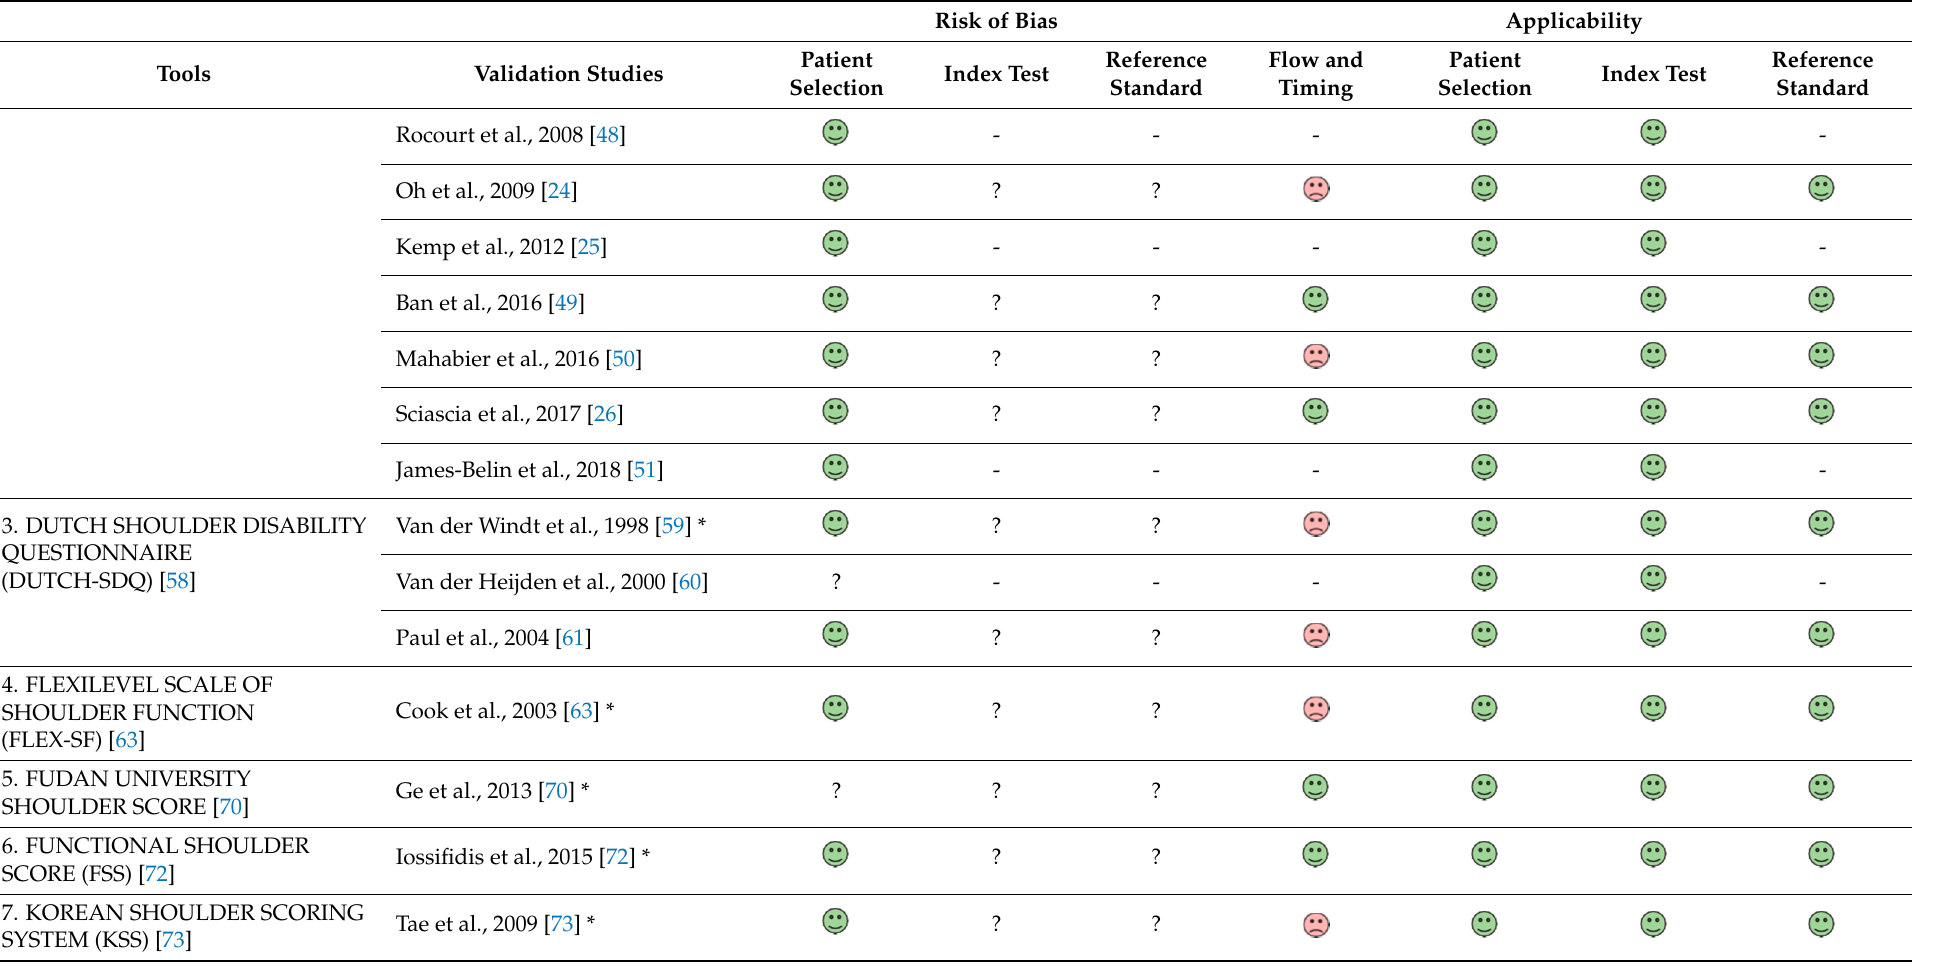
Table 3. Assessment of the methodological quality with QUADAS ‐ 2.